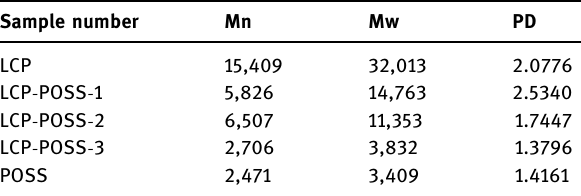
Table 2: Reaction condition and partial results of the synthesis of LCP - POSS liquid crystalline behavior